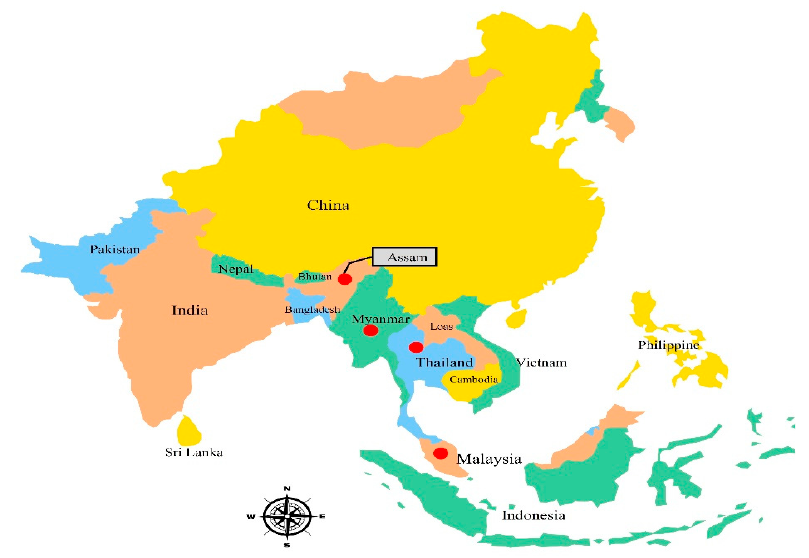
Figure 1. Geographical distribution of G. atroviridis. Red spots represent the distribution of G. atroviridis.